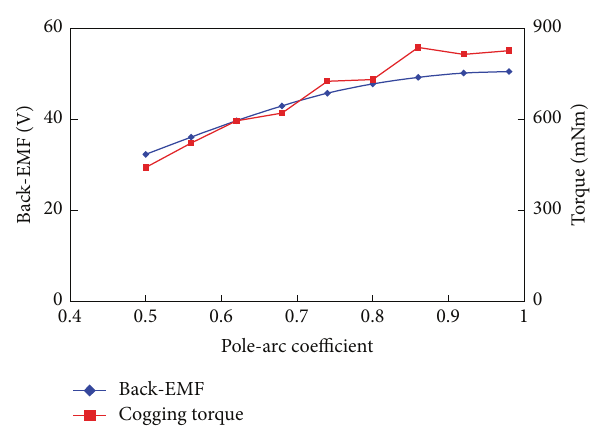
Figure 9: Peak value variations of back-EMF and cogging torque with PM pole-arc coefficient 𝛼 .